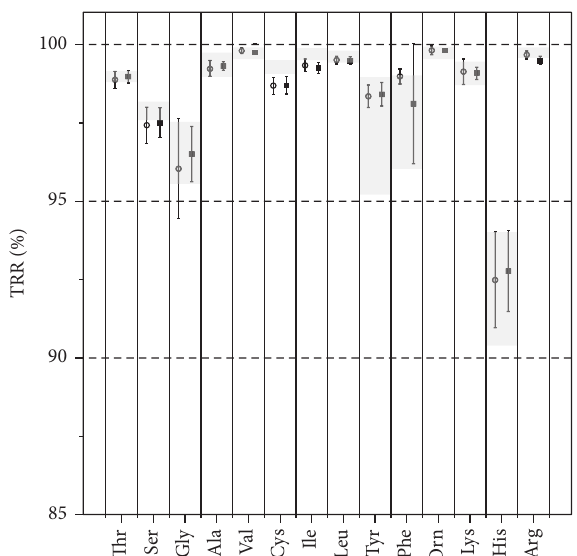
Figure 2: Renal tubular reabsorption of free amino acids (TRR%) compared between group Tob − (o = CF patients that never received intravenous tobramycin) and group Tob+ ( ◼ = CF patients that received various courses of intravenous tobramycin). Gray shad- owed areas represent the normal